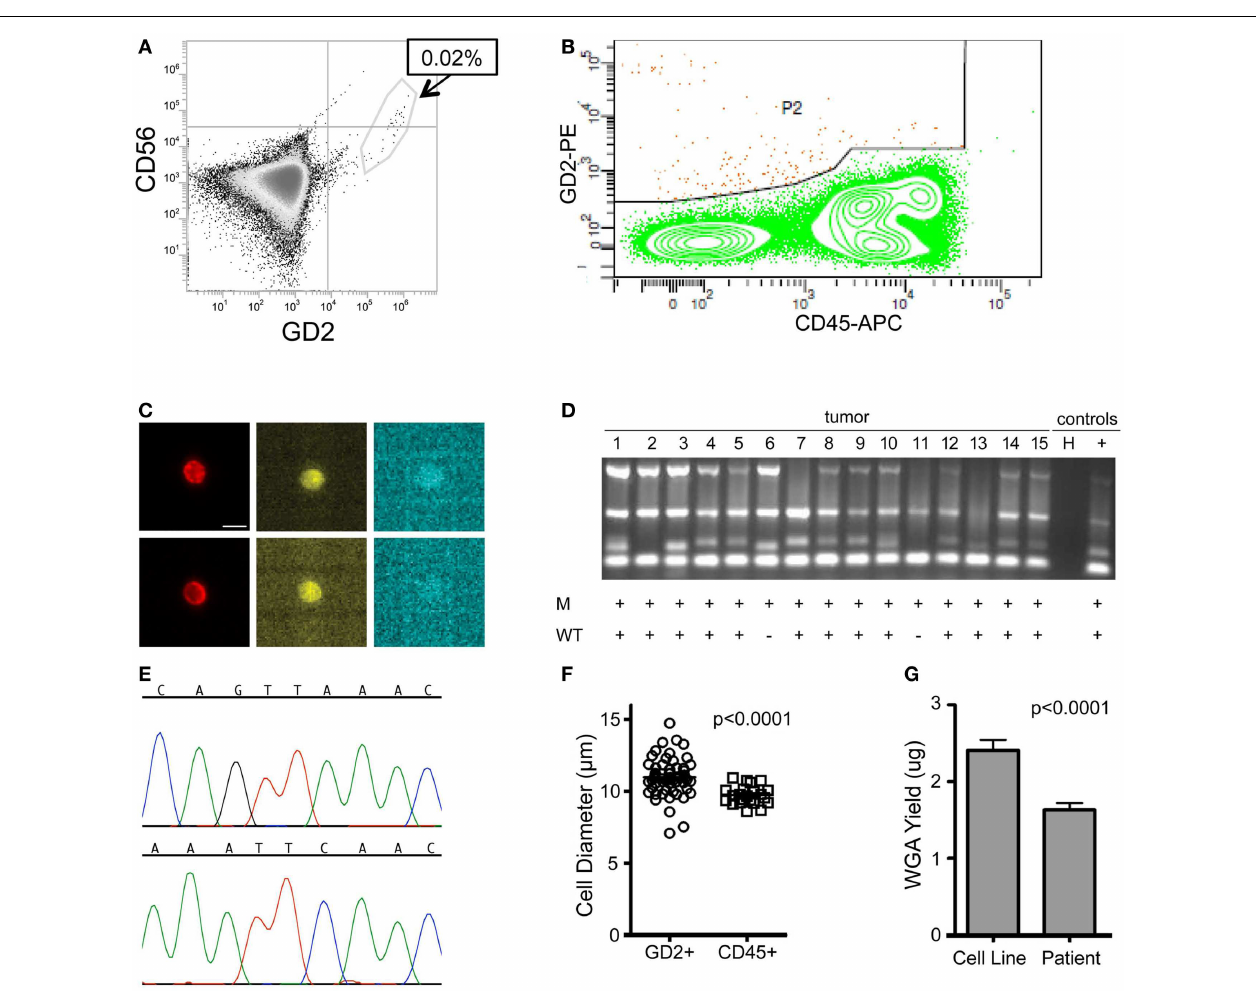
either the mutant allele (top row labeled “M” or the wild-type allele bottom row labeled “WT”). (E) The chromatogram of the wild-type (top) and mutant allele (bottom) for cell #8. (F) Diameter of patient cells, as measured for 56 tumor cells and 22WBCs while in solution on the DEPArray chip. (G) Bone marrow samples of patients were processed as described above and direct fluorescent staining used to measure the DNA concentration ofWGA product from single cells. MeanWGA yield for n = 64 patient single cells is shown in comparison to the yield for n = 31 single tumor cells from cell line spiking experiments. In this analysis, all patient and cell line cells were